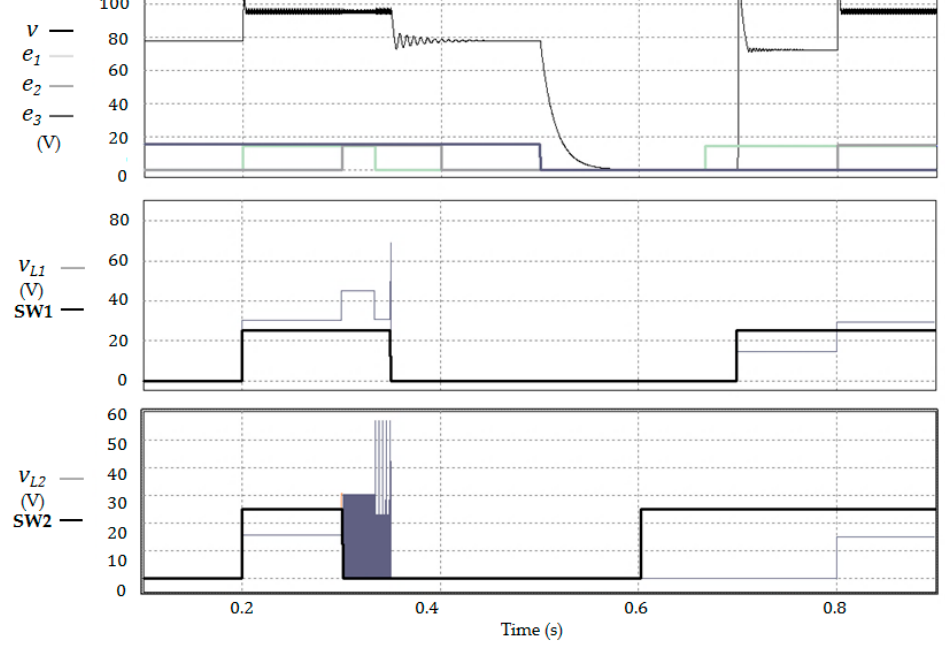
Figure 7. PI closed-loop with failure events and unreachable reference.